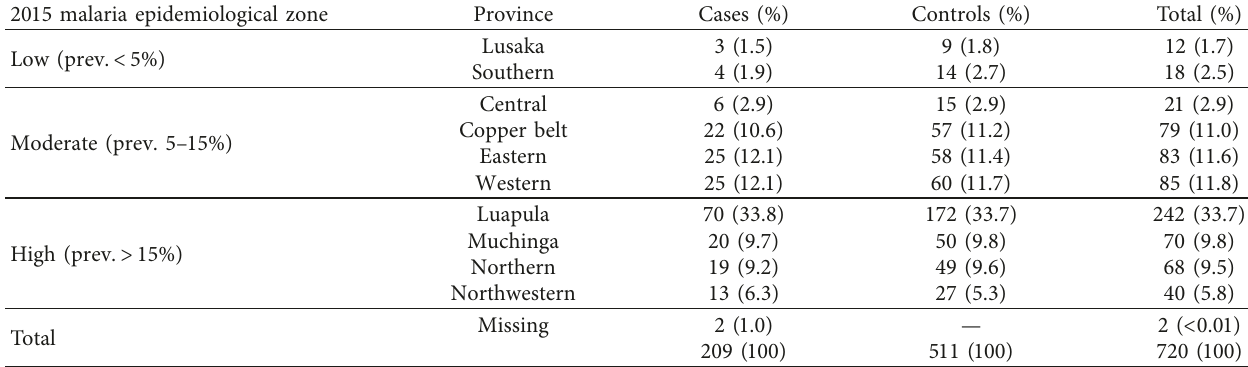
Table 1: Number of malaria cases and controls per epidemiological